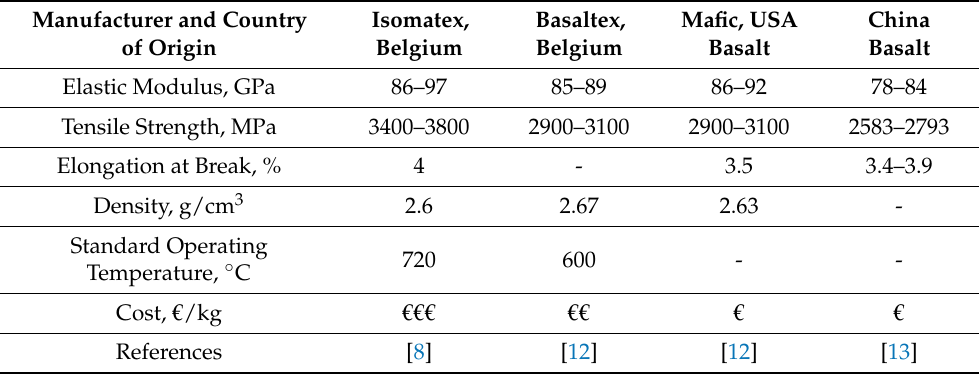
Table 2. Comparison of Filava fibres to various basalt fibre according to ASTM D2343. Manufacturer and Country